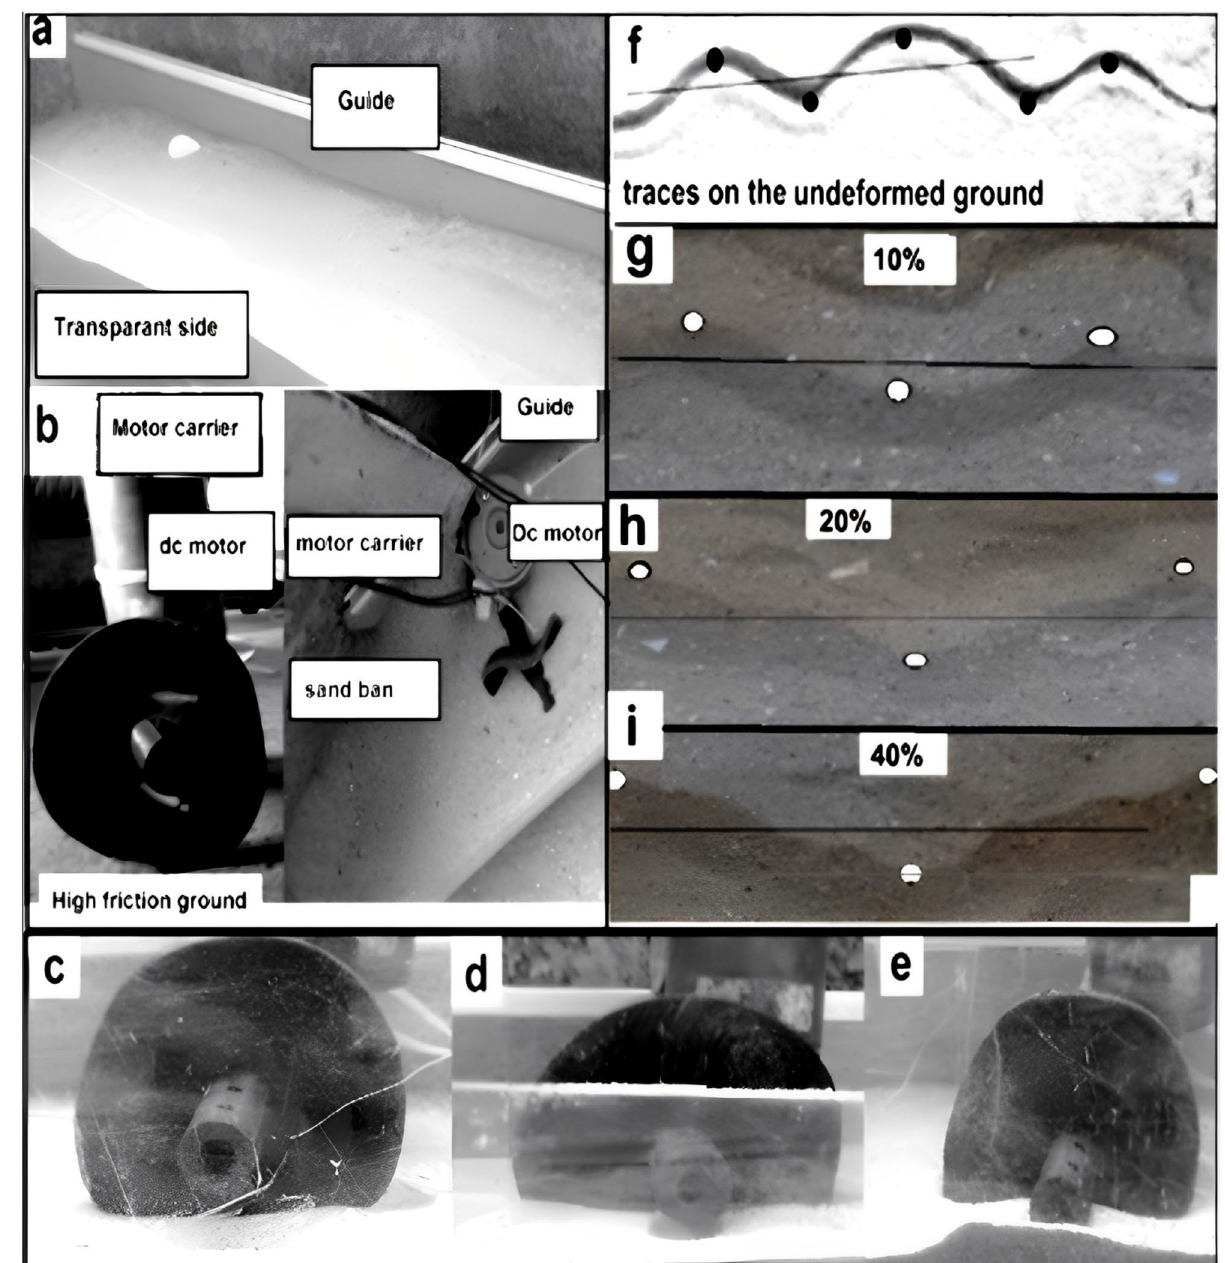
Figure 6. The experimental facilities to assess the built wheel performance ( a ) sand bin ( b ) motor carrier ( c , d , e ) sinkage heights of the wheel ( f , g , h , i ) The wheel’s traces.